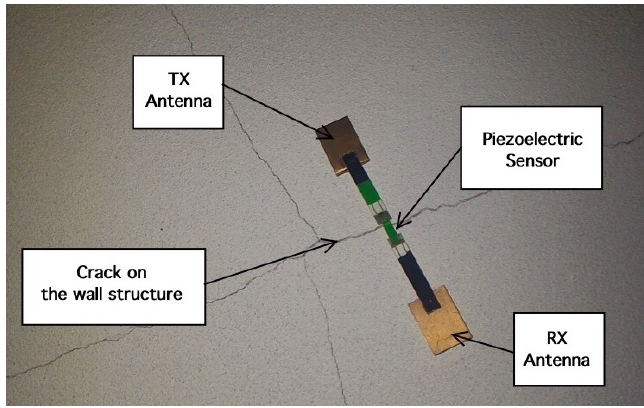
Figure 8. Photo of the crack and the tag placed on position B North side of the